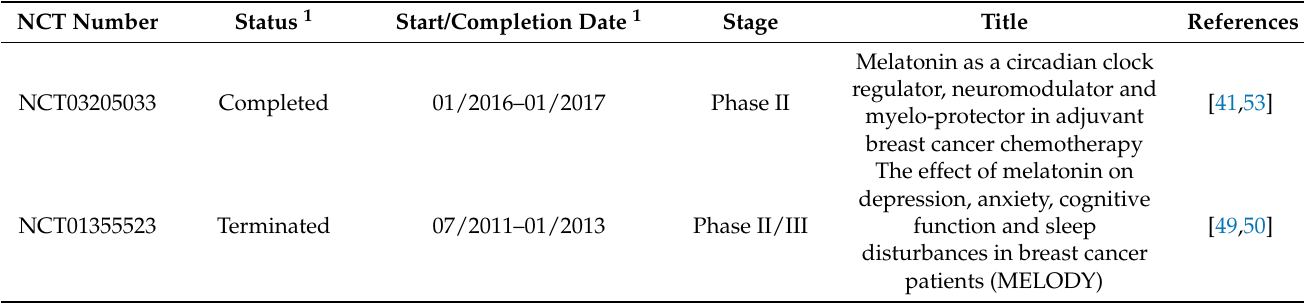
Table 1. Clinical trials with melatonin in breast